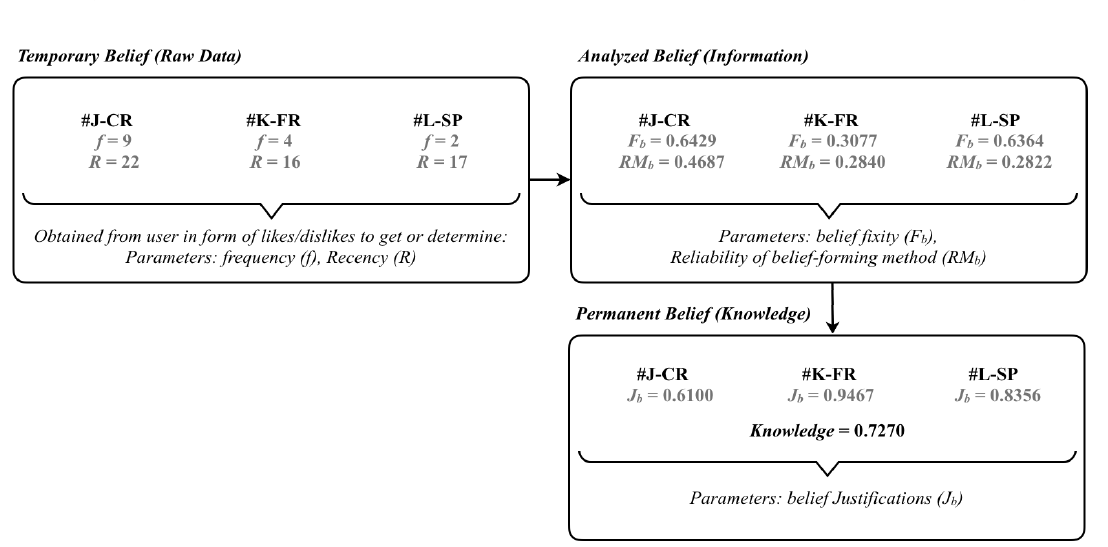
Figure 8. Application of the KDI model for assigning weightage to each user’s preferences .